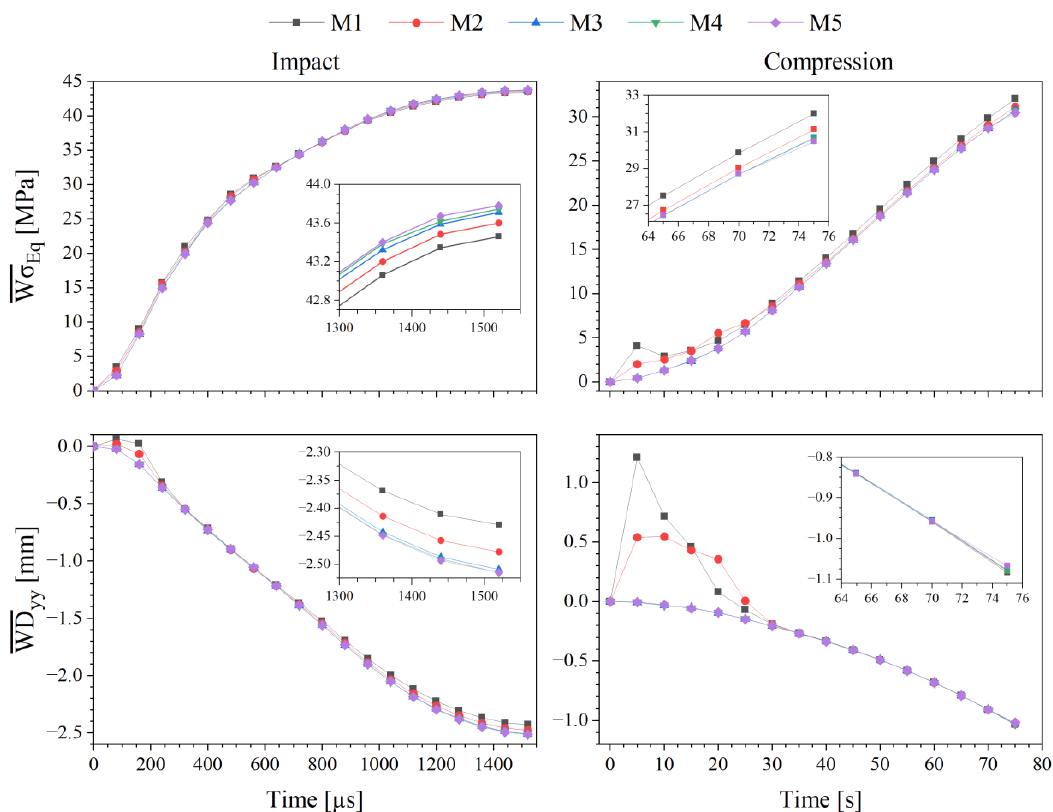
Figure 9. Analysis of the average von Mises stress and y-displacement evolutions as a function of mesh size for impact and compression simulations.